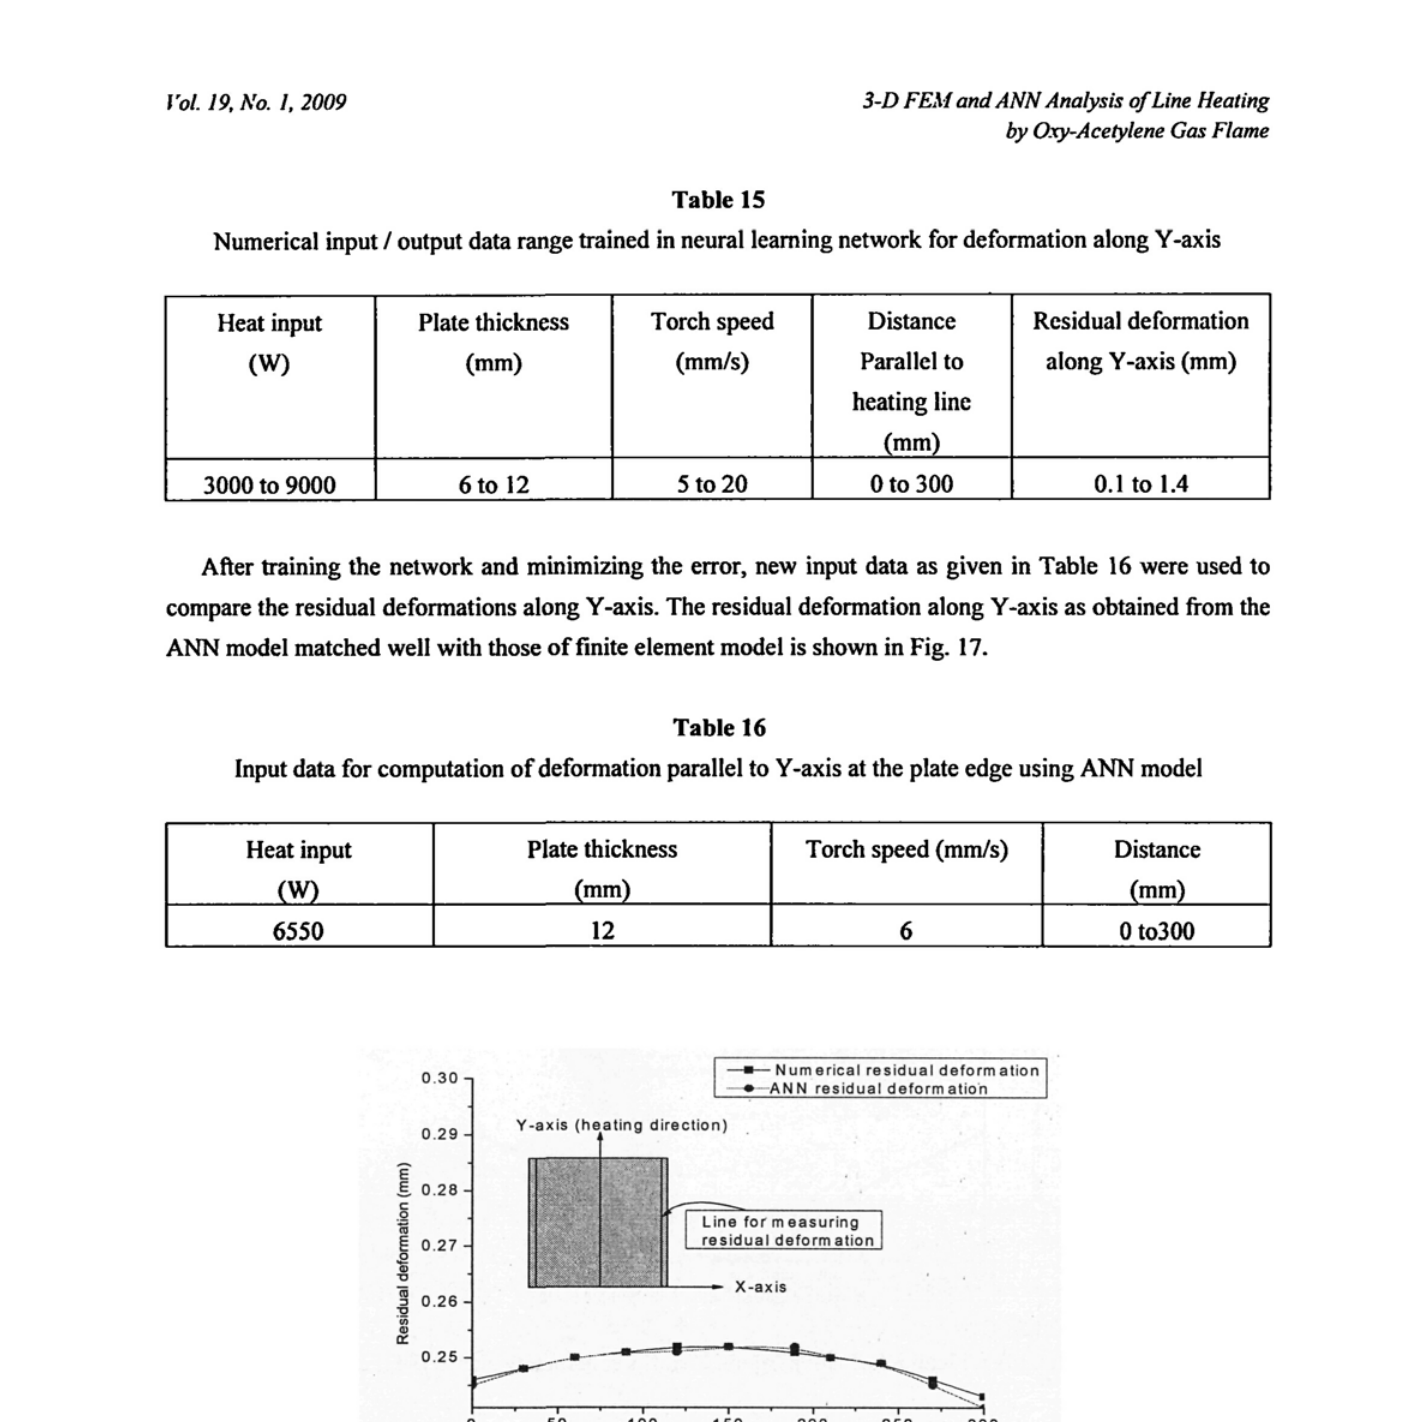
Fig. 17: Comparison of the residual deformations along the line heated plate for 12mm thick plate